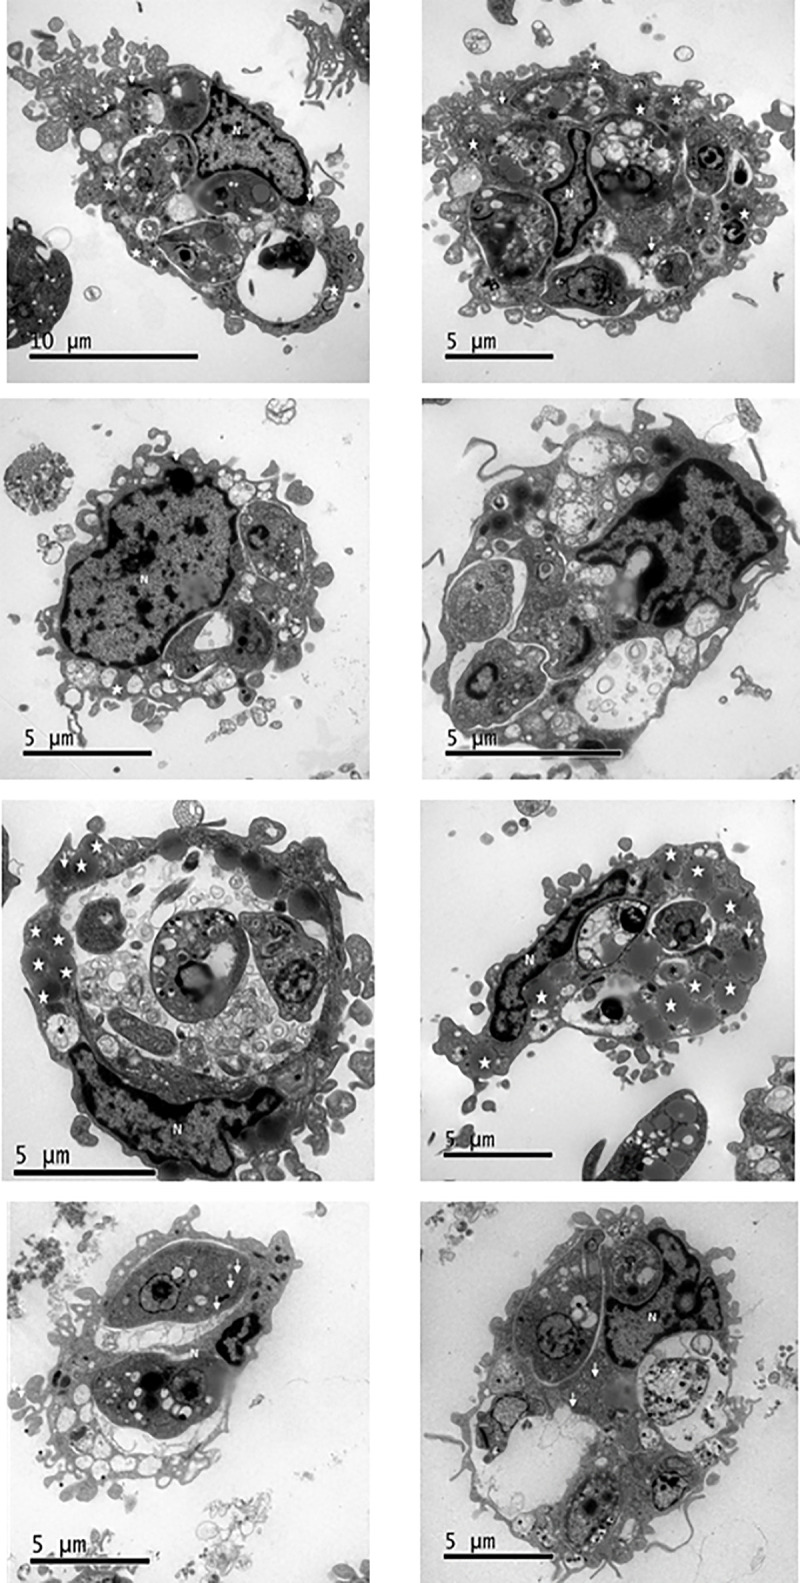
Alterations in Leishmania (Viannia) panamensis-infected hMDMs’ ultrastructures.Untreated infected hMDMs (a and b). Infected hMDMs treated with compounds (c and d) 1, (e and f) 2, and (g and h) 8. White arrows, mitochondria; white asterisks, double-membrane vacuoles (autophagosomes); white stars, electrodense bodies. Visualization scale = 5–10 μm; 10,000x magnification. hMDMs, human monocyte-derived macrophages; N, nucleus; PV, parasitophorous vacuole; TEM, transmission electron microscopy.